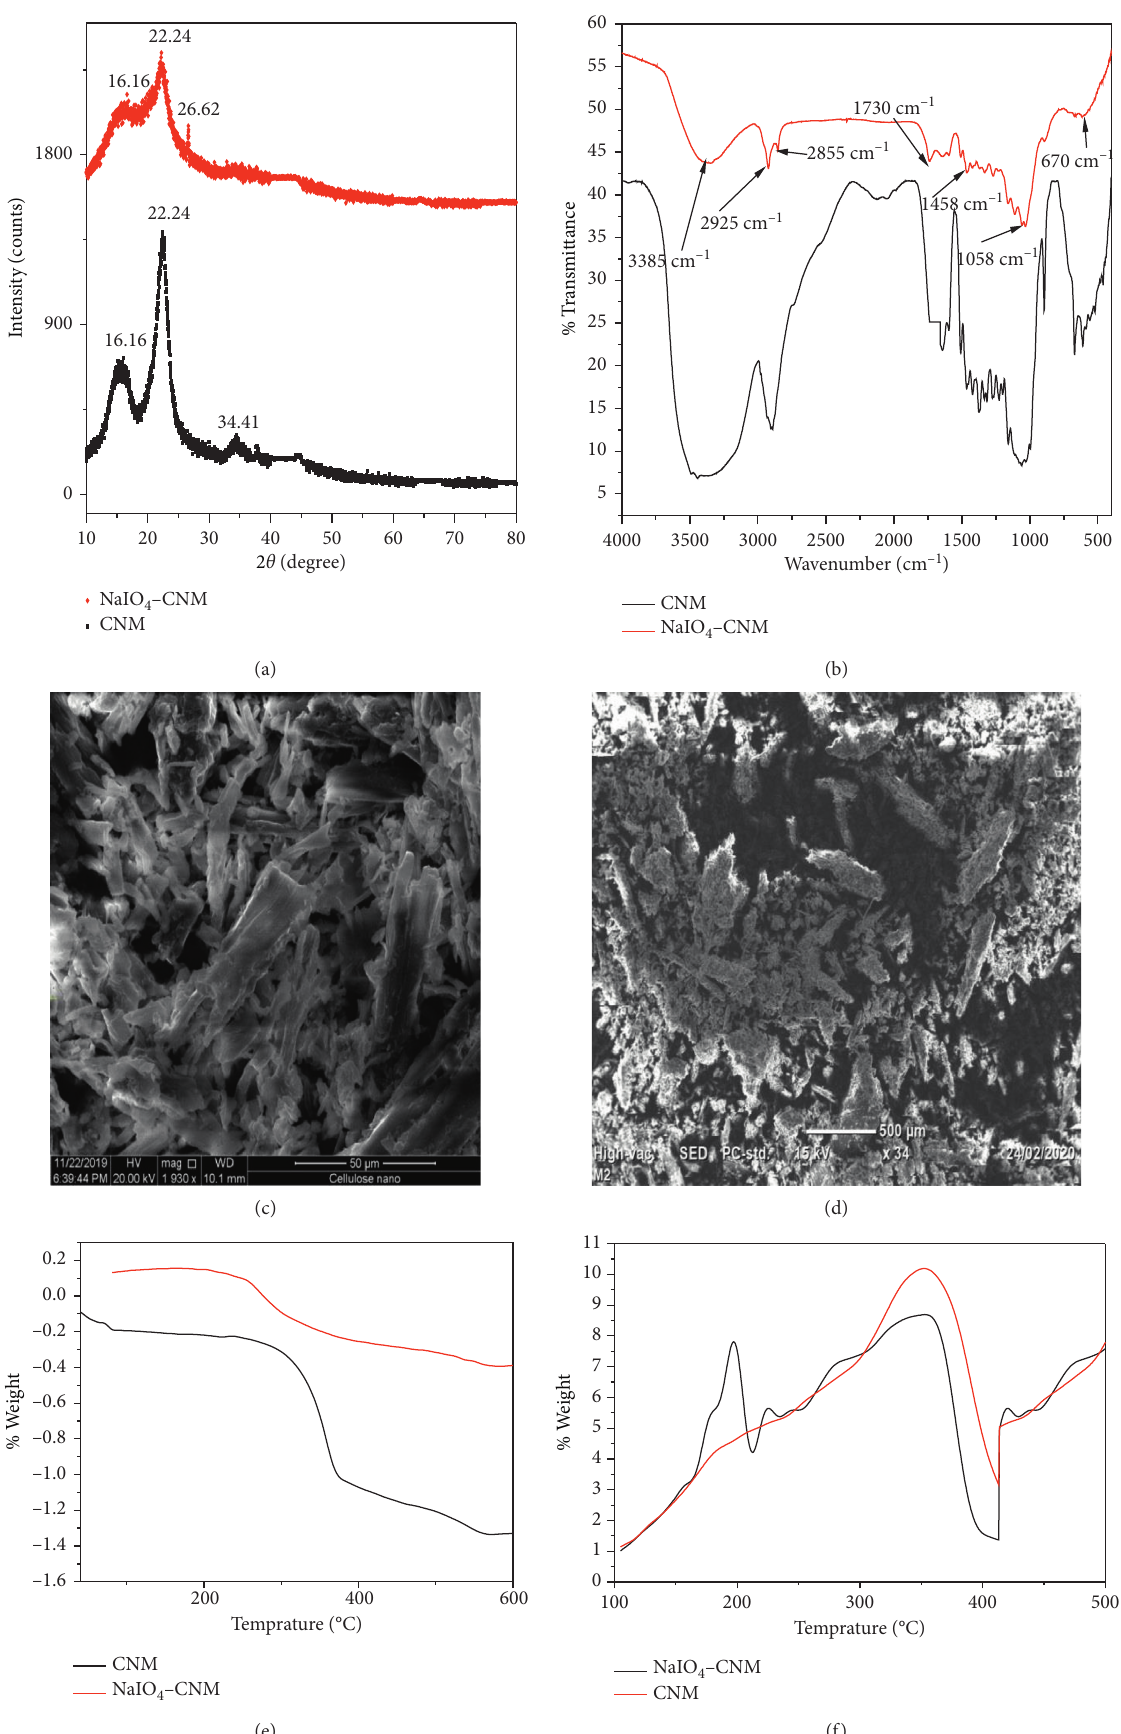
Figure 3: (a) XRD pattern, (b) FT-IR spectrum, (c, d) SEM images, and (e, f) TGA-DTG of CNM and NaIO